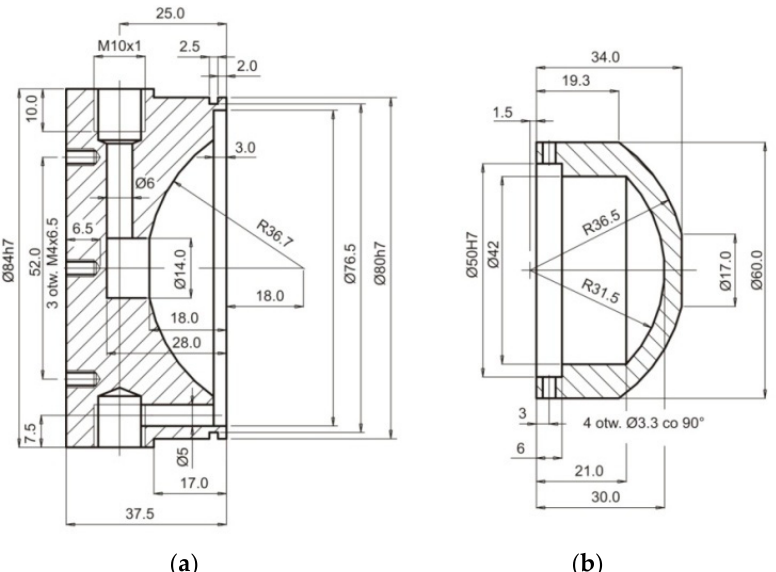
Figure 7. Geometric features: ( a ) TE—material—electrolytic copper, ( b ) WP—material—hot work steel 2312.